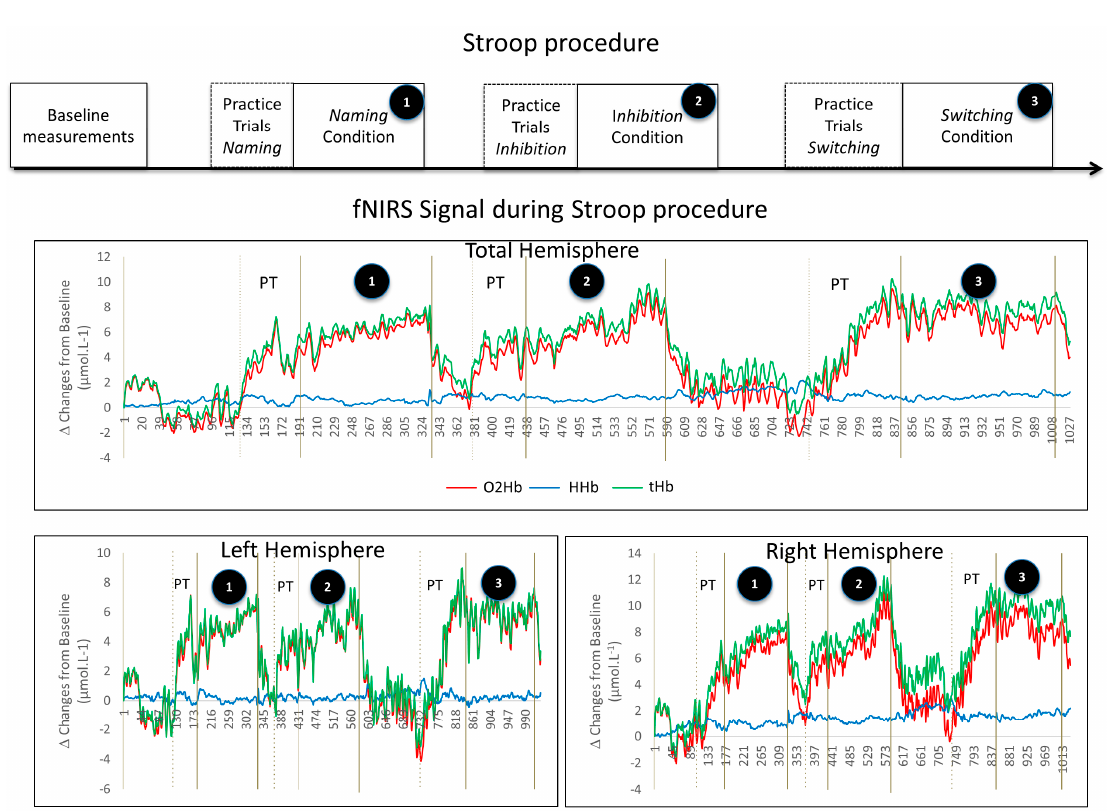
Figure 3. Typical response of cerebral oxygenation during the Stroop procedure. (PT= practice trials).